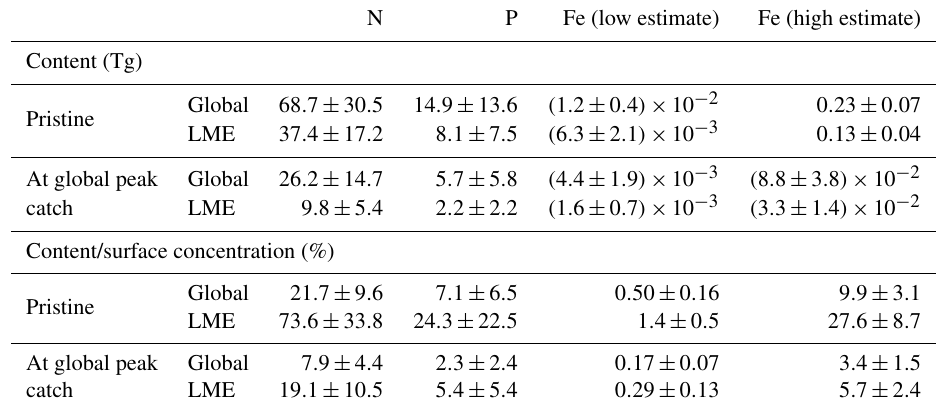
Table 2. Table of values in LMEs from the model ensemble simulations in the pristine state and at the global peak catch. This table contains integrated values of nutrient content in CTF 100kg biomass (Tg) and the ratio of nutrient content in CTF 100kg 10g concentrations (%).